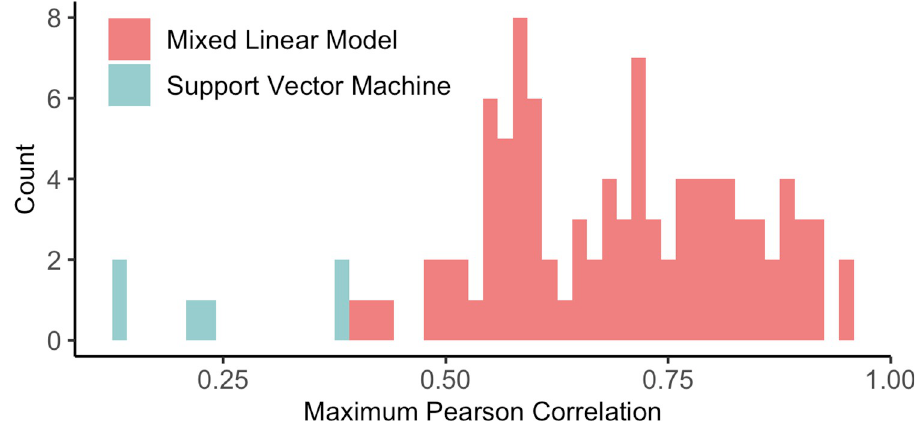
Fig 2. Correlation of metabolites associated with wooden breast. Maximum pairwise correlation among the 98 significant metabolites in the wooden breast mixed linear model analysis (pink) and among the 6 metabolites included in our final support vector machine